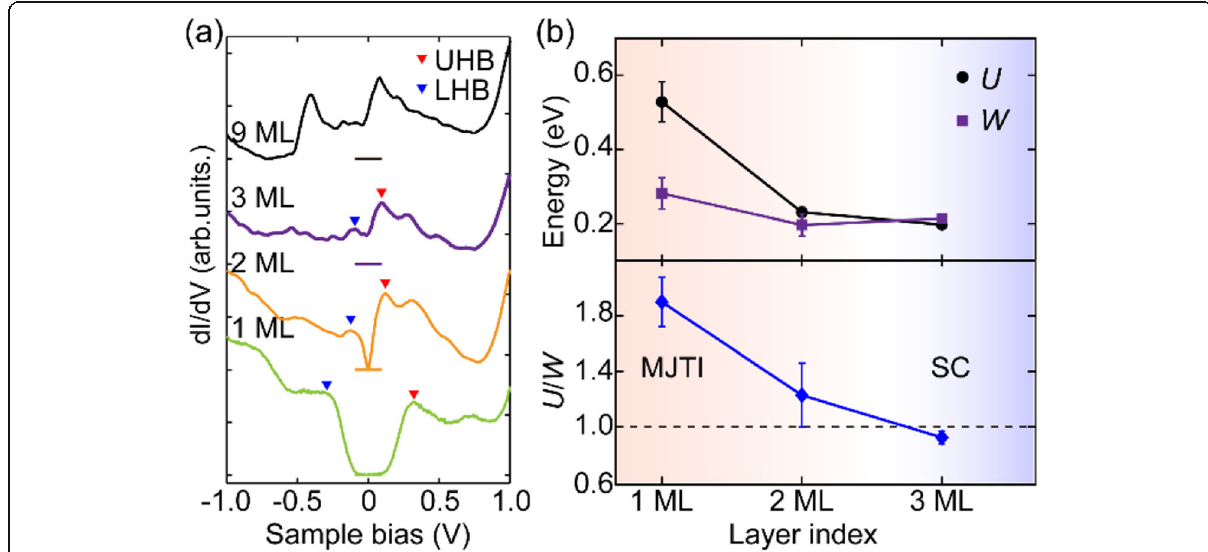
Fig. 14 ( a ) Thickness-dependent d I /d V spectra of K 3 C 60 . ( b ) Measured Hubbard U , W (upper panel), and U / W (lower panel) of K 3 C 60 as a function of thickness. Taken from ref. [45]